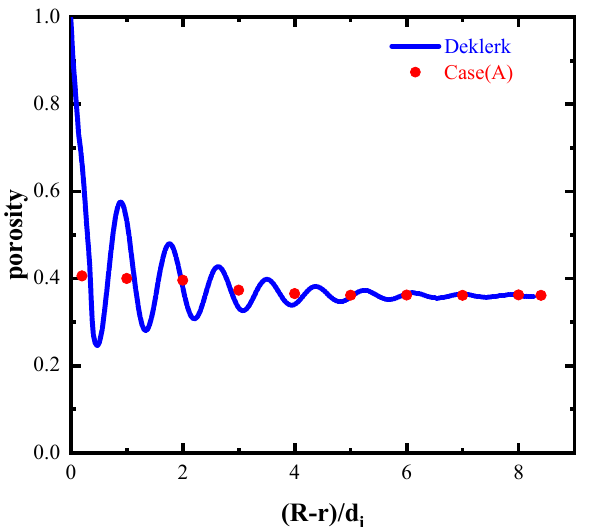
Figure 3. Comparison of the average radial porosity between simulation and experimental data of Klerk et al. [35].